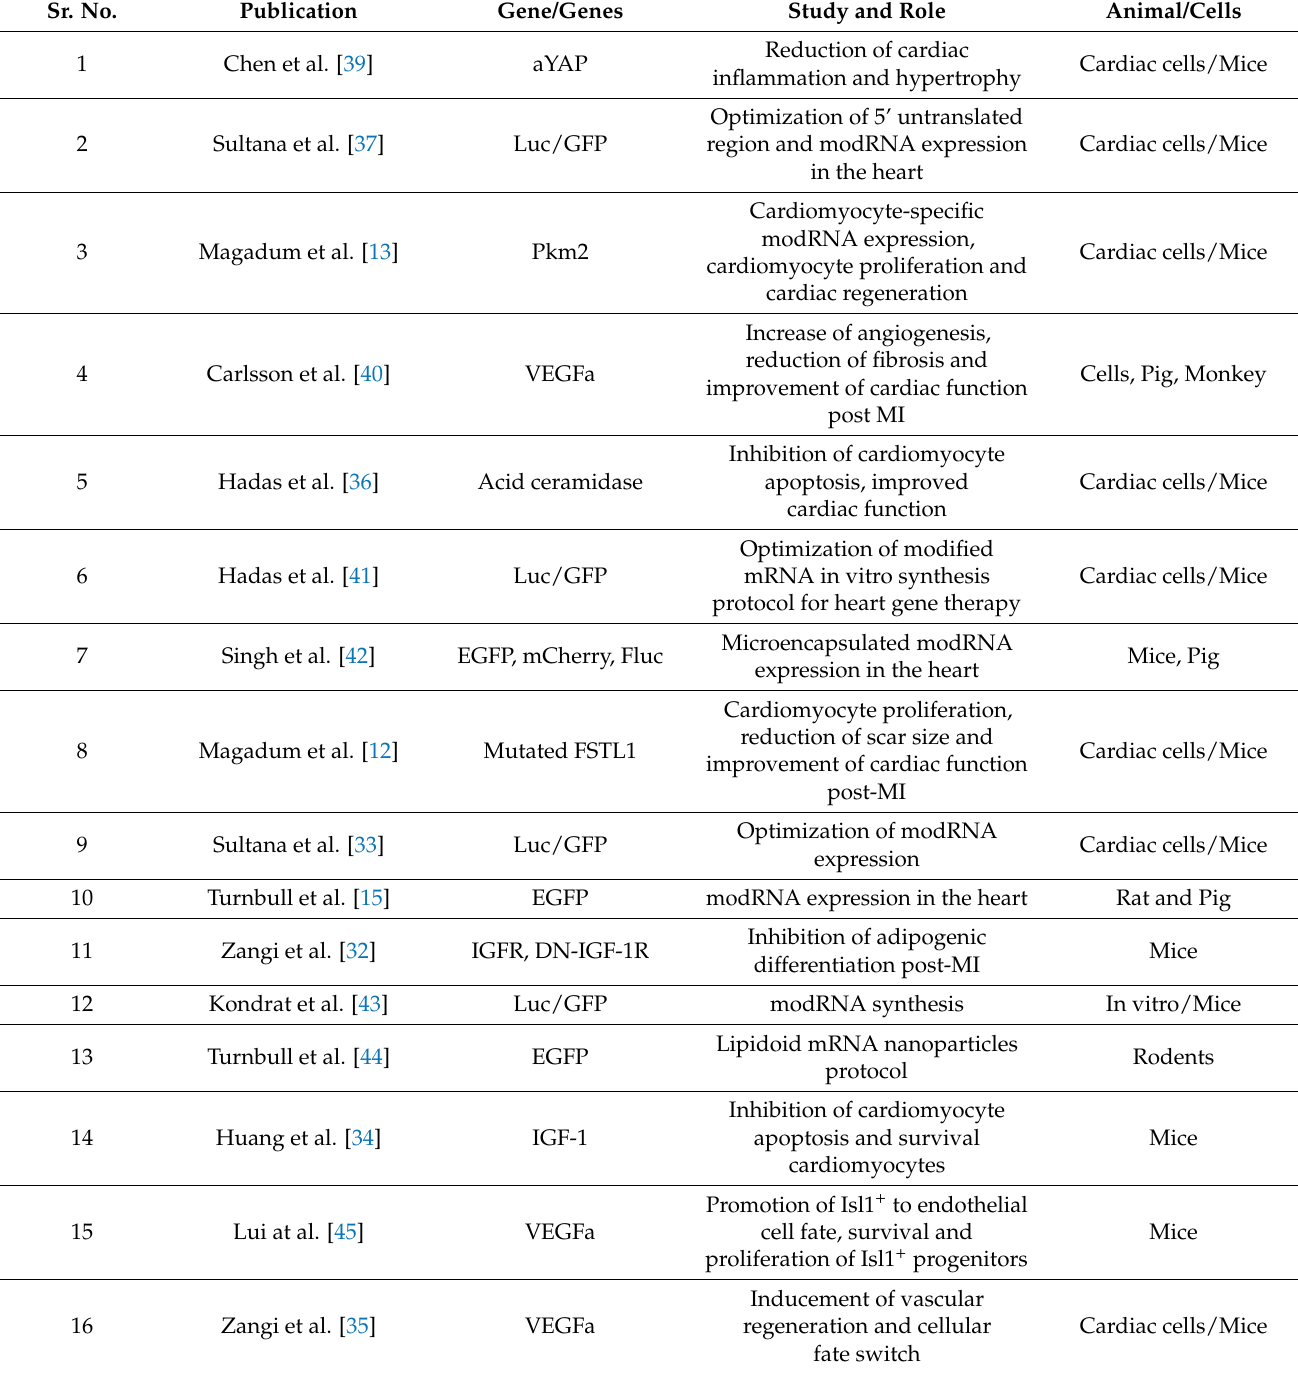
Table 2. Published work showing use of modRNA based gene delivery for heart diseases and